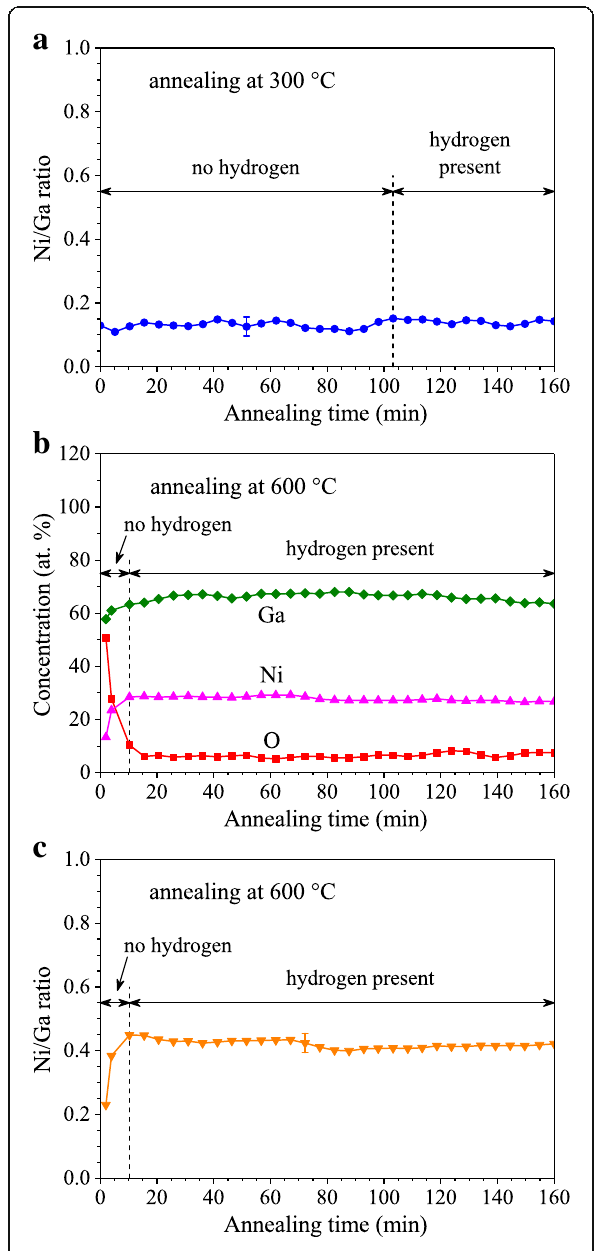
Fig. 6 a Time dependence of the Ni/Ga concentration ratio in the surface layer (3 – 5 nm depth) during annealing at 300 °C. b Time dependence of the O, Ga and Ni concentrations in the surface layer during annealing at 600 °C. c Time dependence of the Ni/Ga concentration ratio in the surface layer during annealing at 600